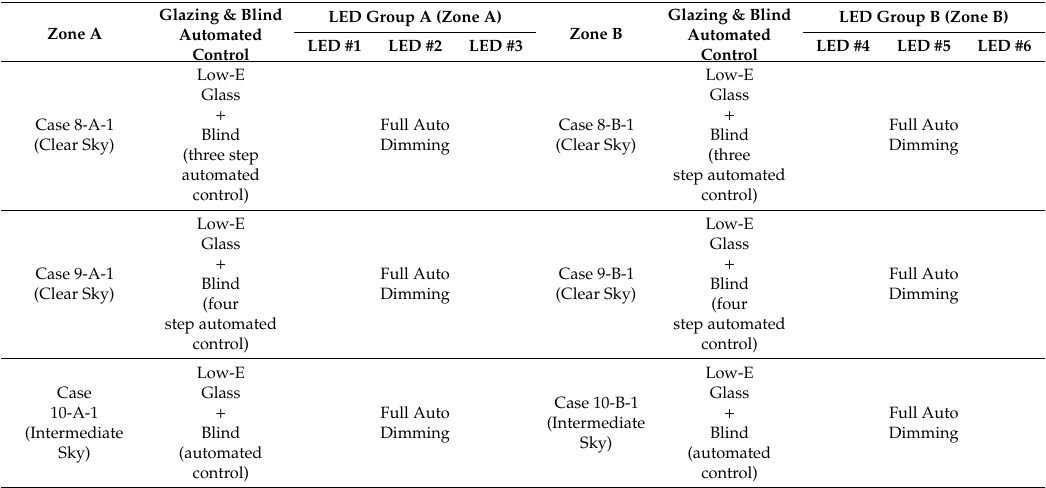
Table 7. Case selection for LED dimming control integrated with automatic blind